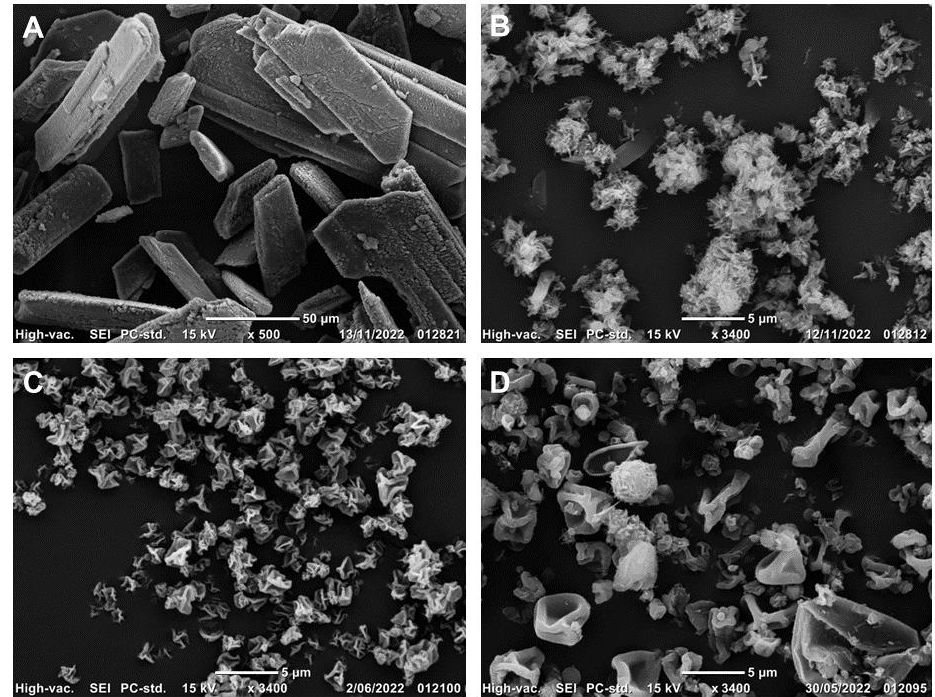
Figure 1. Scanning electron microscopy images displaying: ( A ) Raw nitrofurantoin (Magnification × 500); ( B ) Spray-dried nitrofurantoin (without HPMC; × 3400); ( C ) 2FN (× 3400) and ( D ) 3FN (× 3400).